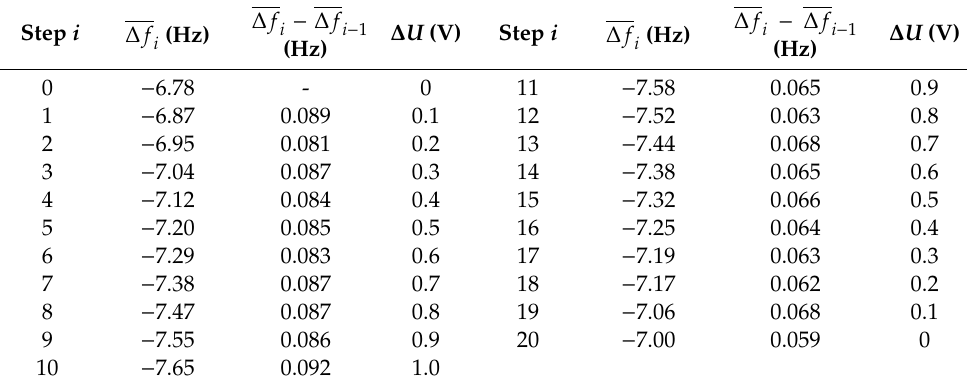
Figure 10. Response of the sensor to small step changes of DC voltage. Table 3. Mean and variation of the di ff erential frequency outputs for step change